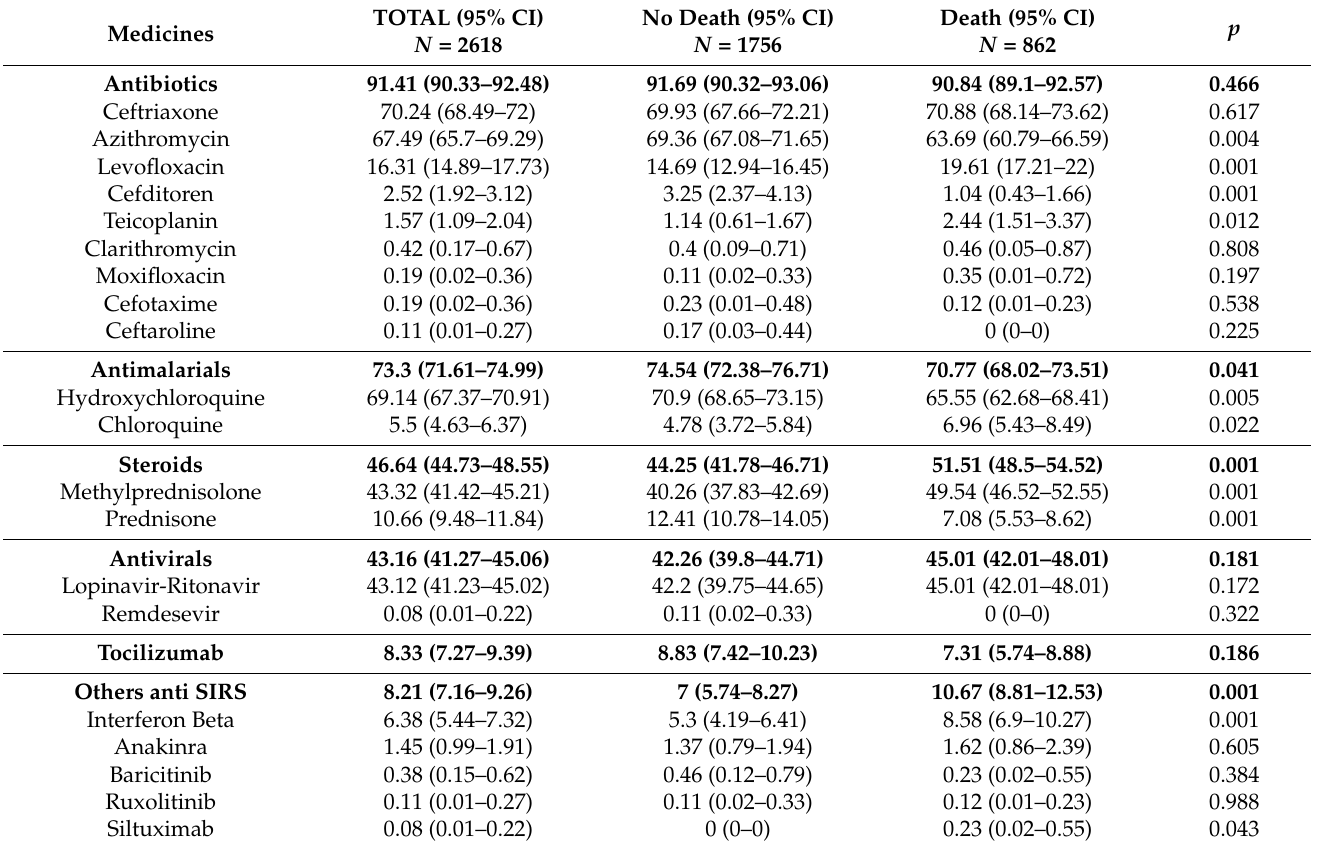
Table 2. Pharmacological treatment in hospitalized COVID-19 patients with previous cardiovascular disease (1